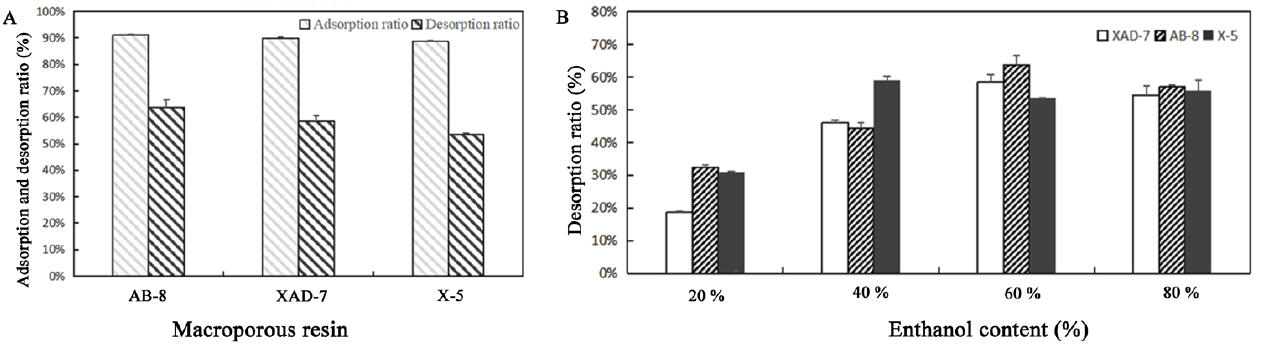
Figure 4. The selection of macroporous resin and eluant content. ( A ) Macroporous resin selection. ( B ) Desorption rate of resin under different ethanol